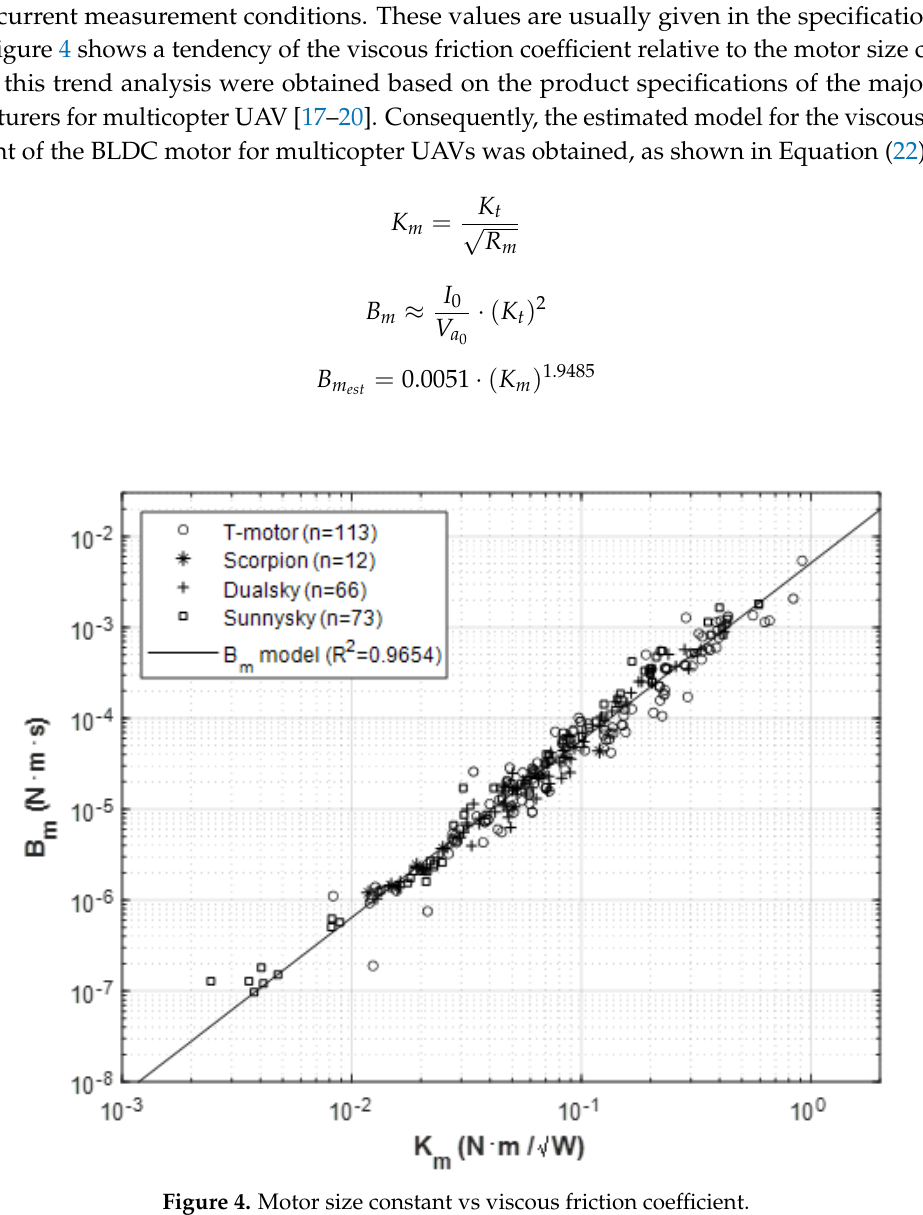
Figure 4. Motor size constant vs viscous friction